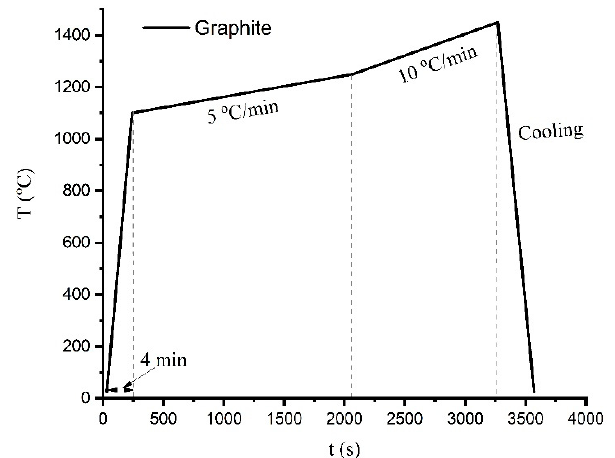
Figure 7. The temperature profile of the Fe-26.38Si-9.35B sample on the graphite substrate in the wetting test.